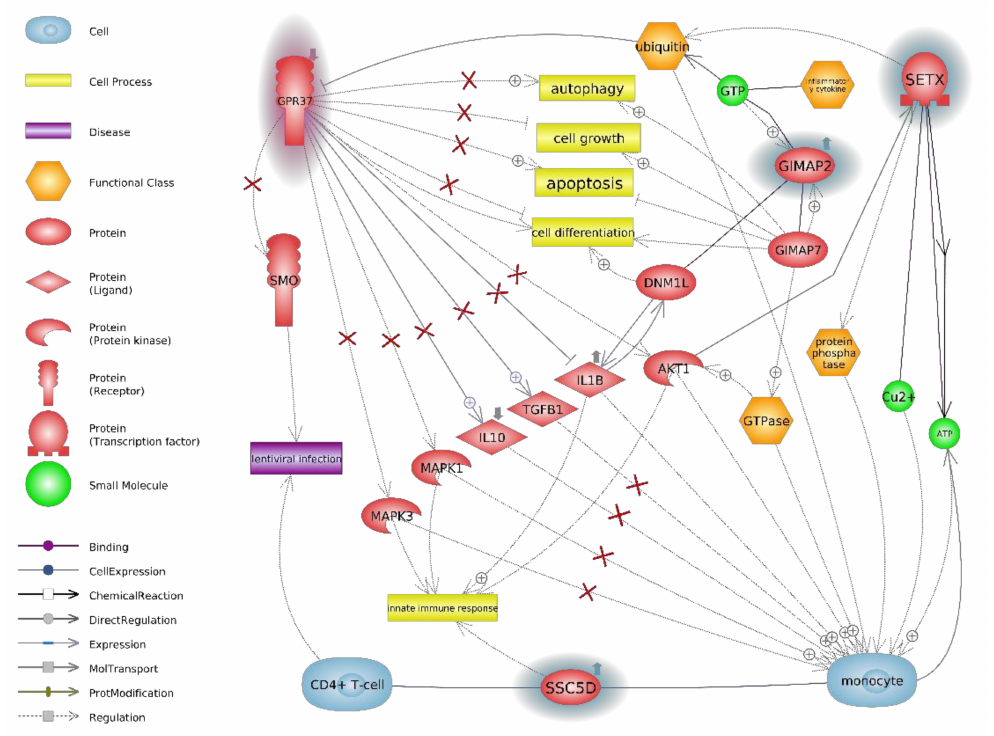
Figure 5. The interactions between proteins, cells, and lentiviral infection for GPR37 in connection with SSC5D, GIMAP2, and SETX on the Capra hircus microarray. Blue highlights upregulation; pink highlights downregulation; GPR37—G